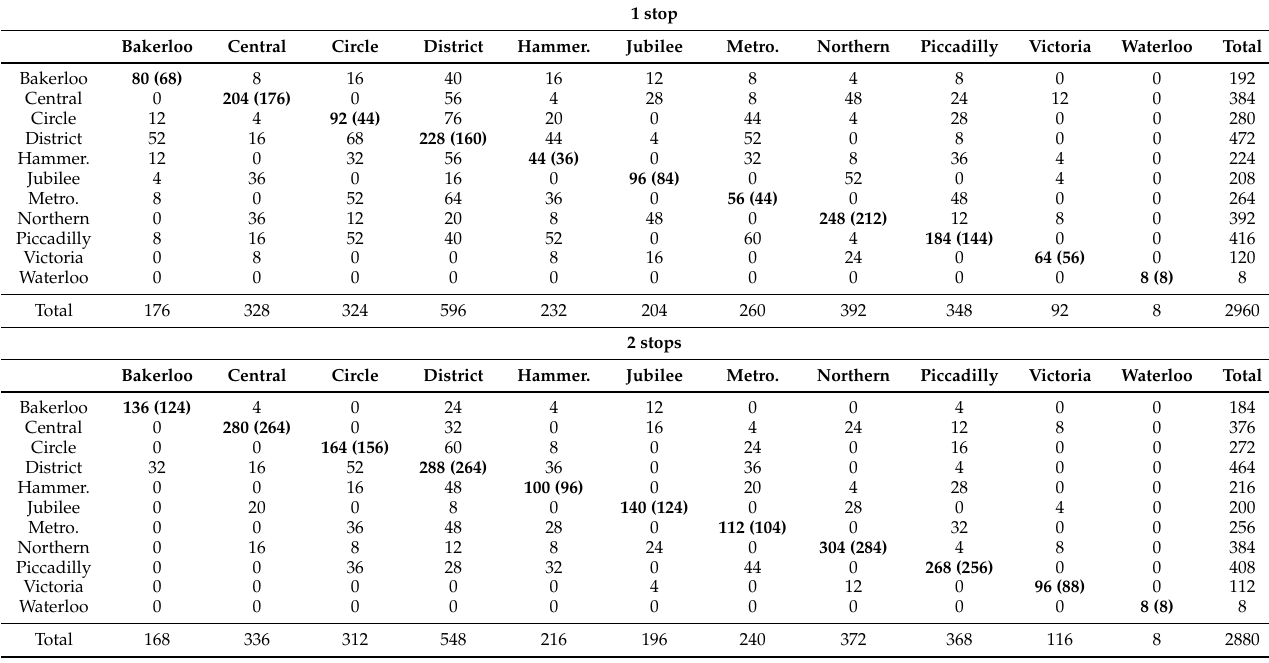
Table 6. The confusion matrix for line and station estimation: The columns represent the true classes. The rows represent our system’s predictions. The diagonal number which is highlighted in bold, reports the correct line classifications for each class, with the number inside the bracket as the correct station estimation. We do not provide the table for 3 stops since only the District and Circle lines were misclassified in this case. Note: Hammer. is short for the Hammersmith & City line and Metro. is short for the Metropolitan line due to space